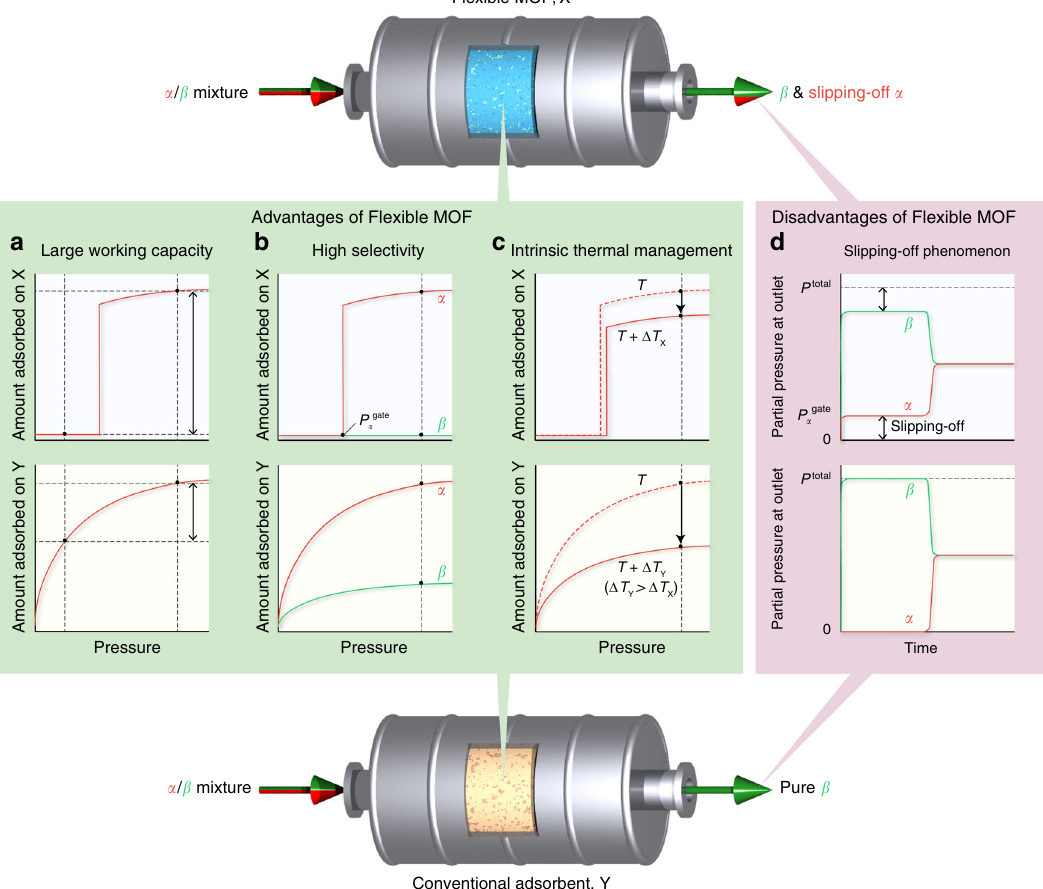
Fig. 1 Advantages and disadvantages of fl exible metal – organic frameworks (MOFs). a Stepwise change in the amount adsorbed due to the gate-opening of the fl exible MOF, X, can provide a larger working capacity when the same pressure swing is considered for the fl exible MOF and the conventional adsorbent, Y. b For a gas mixture adsorption (components α and β ), the fl exible MOF can give higher selectivity for component α than the conventional adsorbent can give, because the gate-opening is a kind of molecular recognition; in this case, the fl exible MOF can only accommodate component α and shows gate-opening. c When an adiabatic gas adsorption is considered, the temperature rise of the system for the fl exible MOF, Δ T X , is smaller than that for the conventional adsorbent, Δ T Y , and the resulting decrease in the adsorption amount can be suppressed because of the smaller net heat of adsorption of the fl exible MOF owing to its intrinsic thermal management capability. d The fl exible MOF cannot adsorb component α when the partial pressure of α in a gas mixture decreases below the inherent gate-opening pressure of the fl exible MOF, P α gate . Thus, a pure ef fl uent gas (component β ) cannot be obtained at the end of the adsorption column ( “ slipping-off ”